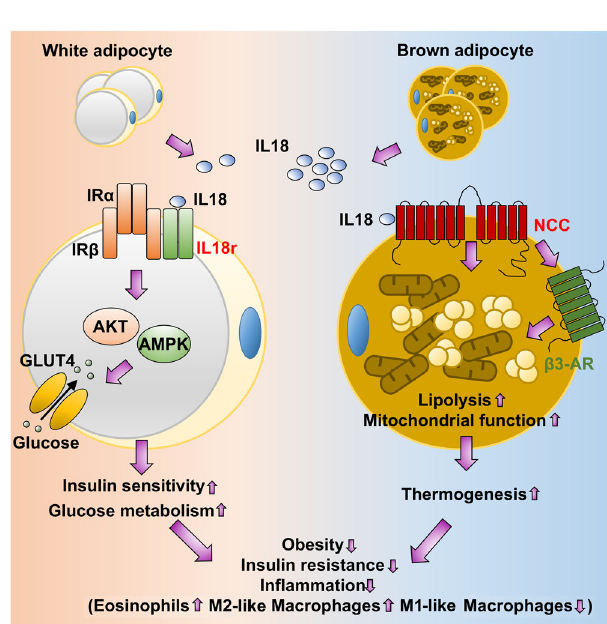
Fig.10|TheproposedmechanismsforIL18signaling-regulatedthermogenesis and glucose metabolism in adipose tissues. IL18 is an adipokine from brown adipocytesinBATandbeigecellsinSAT.NCCmediatesIL18functionsinactivating thermogenesis by regulating mitochondrial functions and lipolysis in BAT in cooperation with β 3-AR. IL18r mediates IL18 activities in promoting glucose toler- ance and insulin sensitivity by regulating IR-AKT insulin signaling and GLUT4- mediated glucose metabolism in EAT. IL18 signaling in adipocytes protects mice from obesity, insulin resistance and adipose tissue in fl ammation.